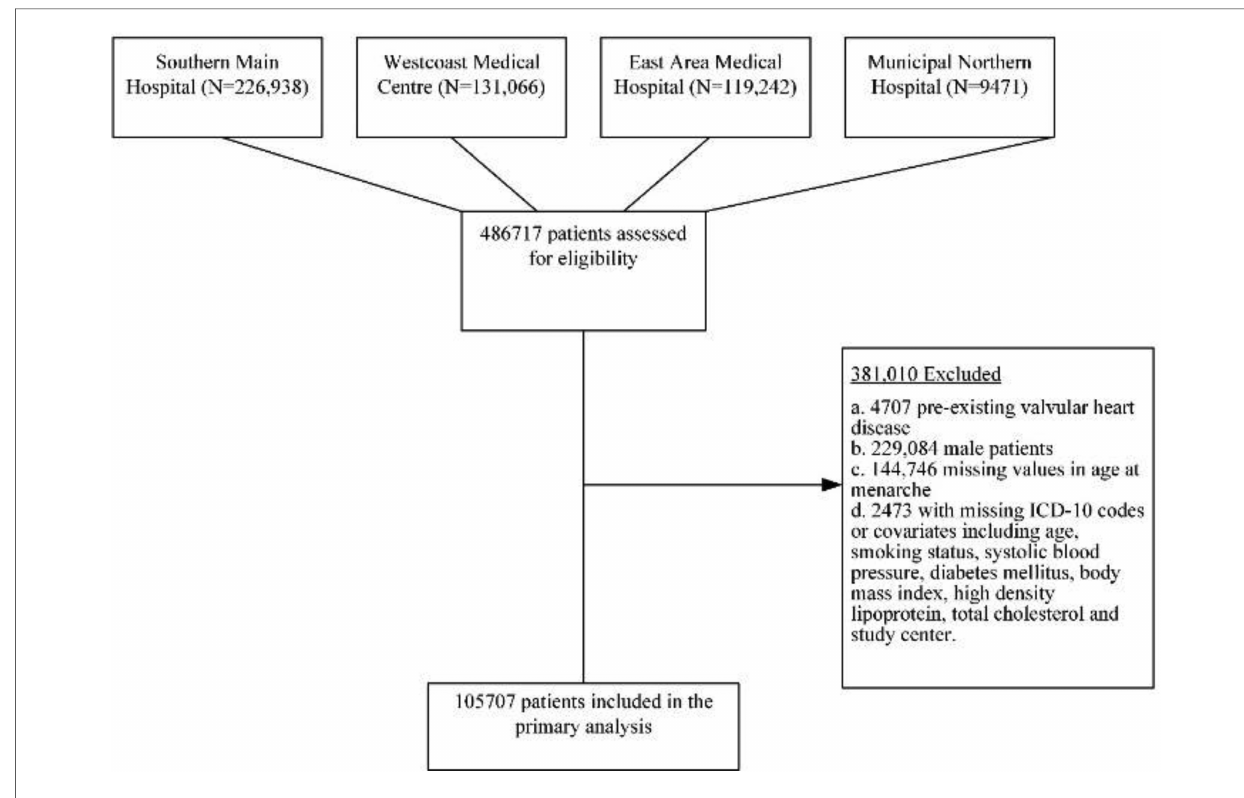
FIGURE 2 Sampling strategy.